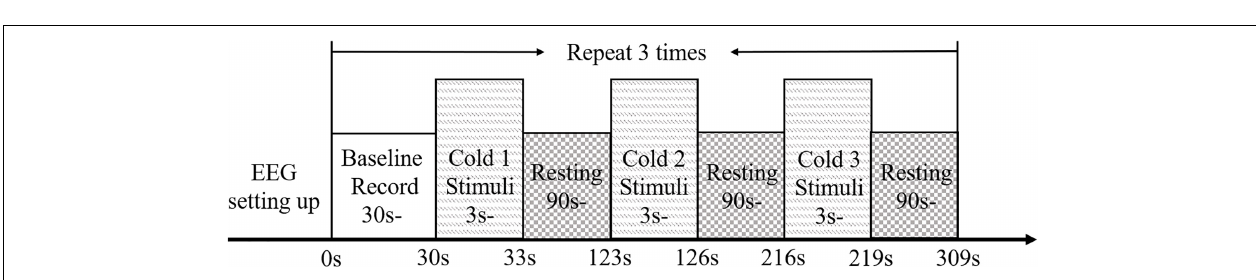
FIGURE 1 | The experimental setup for the EEG evaluation during the non-painful cold stimulation (NPCS): (A) participant in the recording position; (B) demonstration of the NPCS.